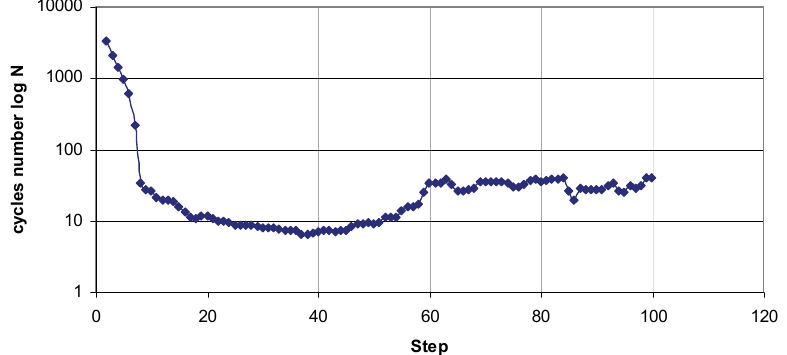
Figure 12: Obtained relationship between steps and number of cycles.